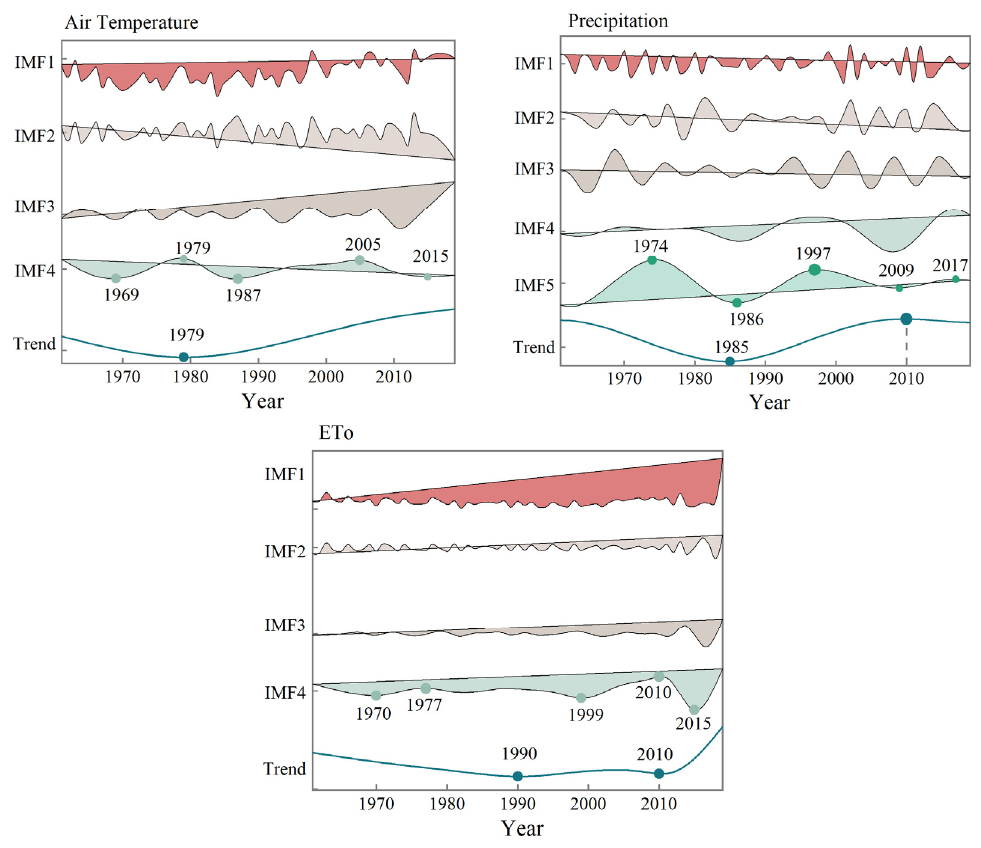
Figure 4. Mode decomposition of meteorological elements.